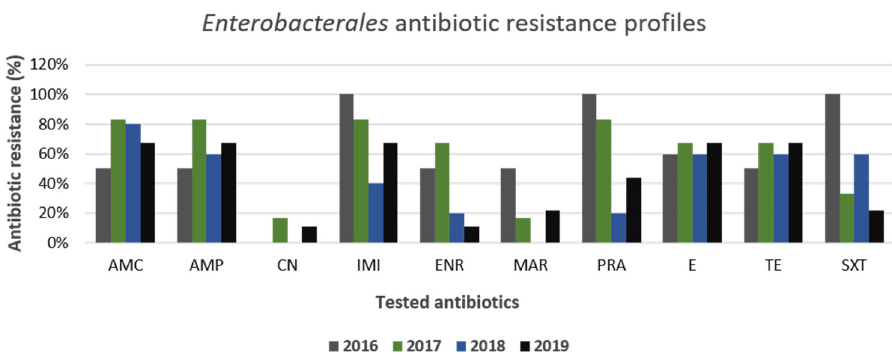
Figure 10. Antimicrobial resistance profiles of canine Enterobacterales strains to commonly used